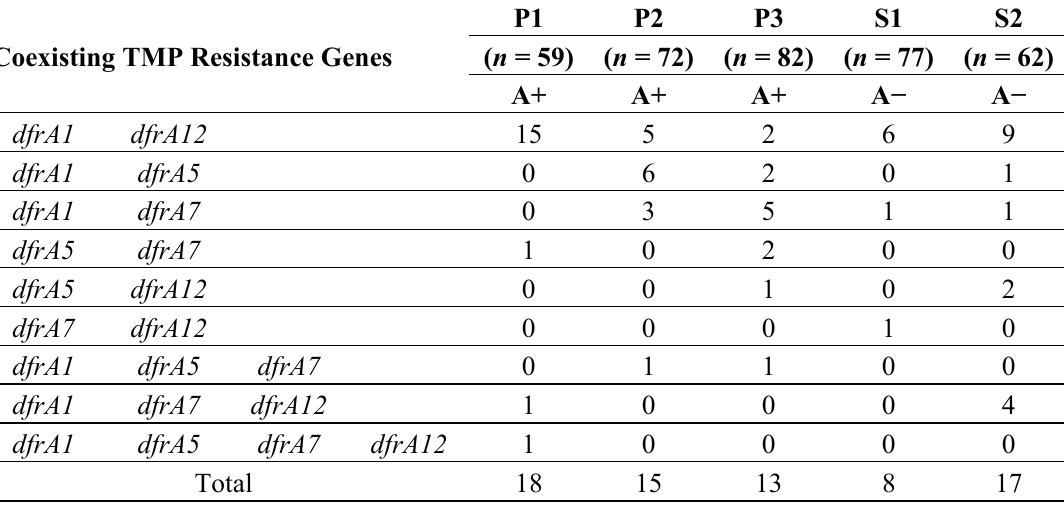
Table 3. Number of E. coli from groups of pigs during metaphylaxis (A+) and in post-exposure period (A − ), with combination of coexisting trimethoprim resistance genes. Coexisting TMP Resistance